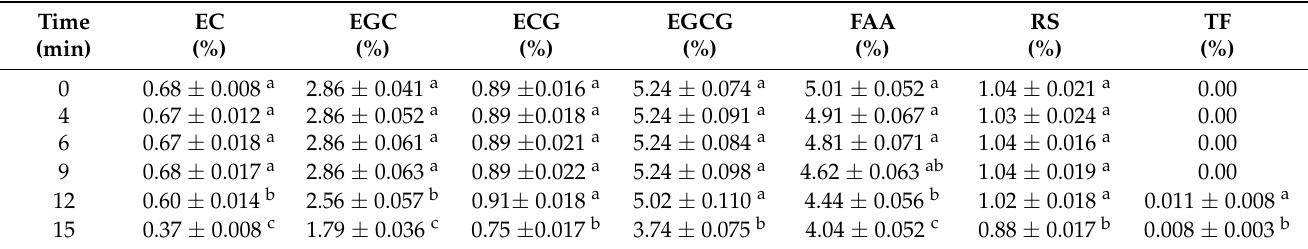
Table 4. The contents of the catechins (EC, EGC, ECG, and EGCG), total free amino acids (FAA), reduction sugars (RS), and theaflavin (TF) in the green tea powder samples treated by microwave radiation of 1000 W with various